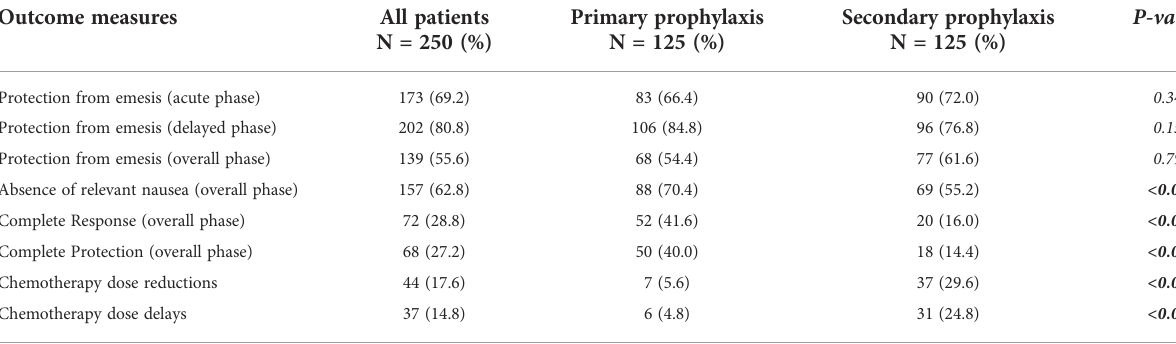
TABLE 3 Analysis of the effectiveness outcome measures in the propensity score matched